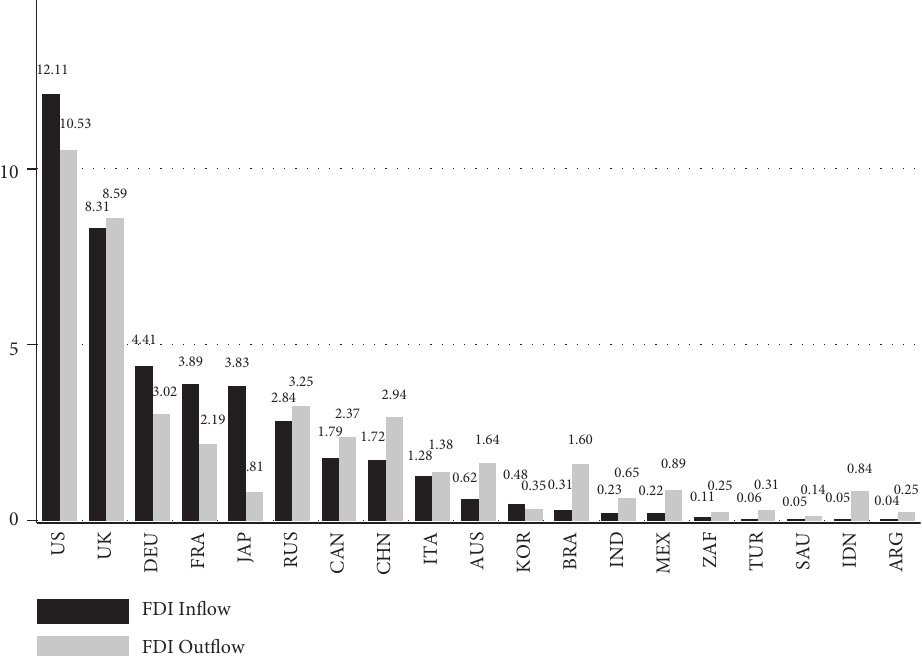
Figure 1: The volume of FDI inwards and